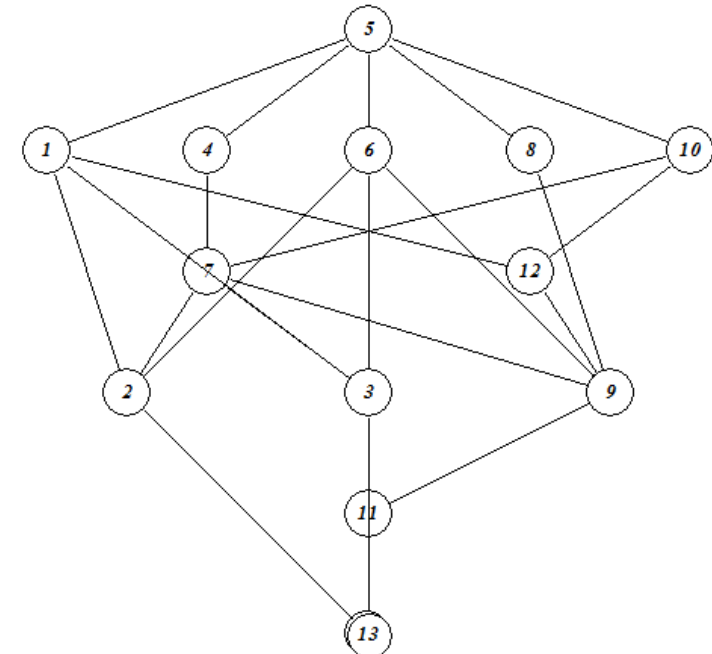
Figure 4 . Hasse diagram constructed based on the parameters CAR, MUT, TER and EMB [6]. For calculation purposes probabilities < 0.5 (denoted NE in Table 6) are for ranking purposes arbitrarily set to 0.25